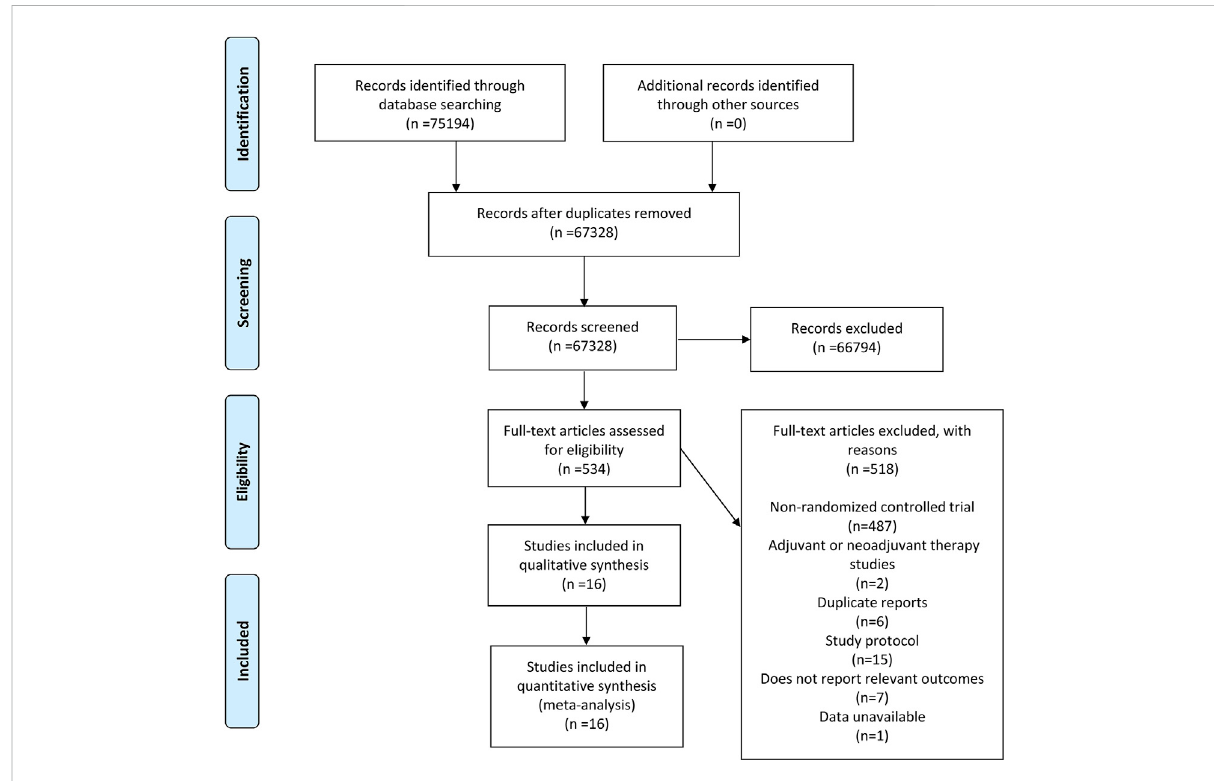
FIGURE 1 Flow diagram describing inclusion and exclusion